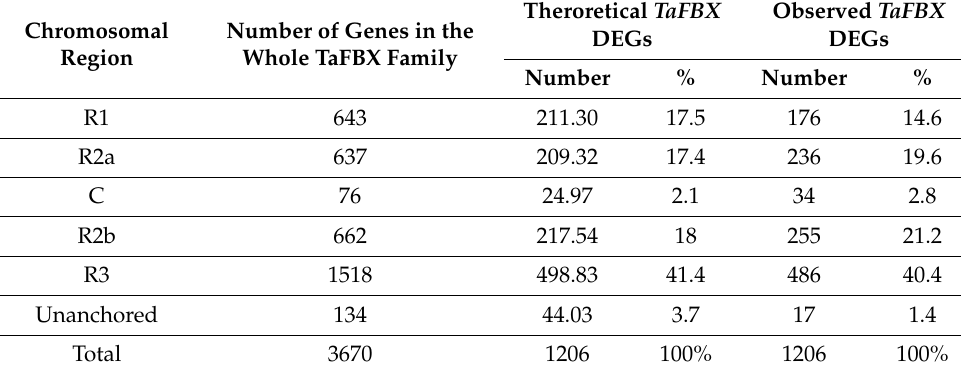
Table 2. Distribution of TaFBX DEGs during embryogenesis and endosperm development, according to their anchorage on chromosomal regions (X-squared test = 20.938, df = 5, p -value = 0.0008322).